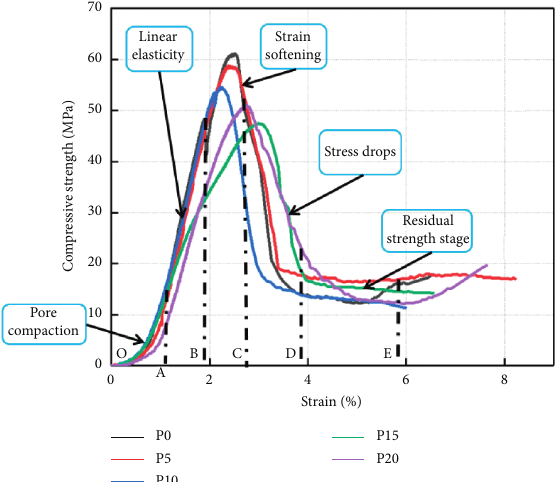
Figure 4: Representative stress-strain curves of 28 days PFCBCM samples with different contents of polyurethane.